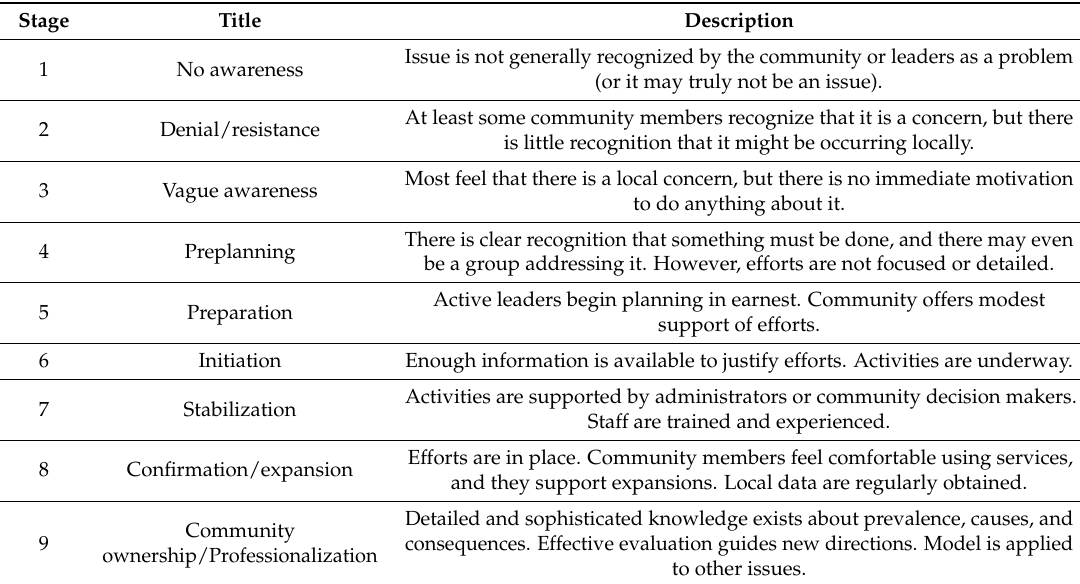
Table 1. Stages of community